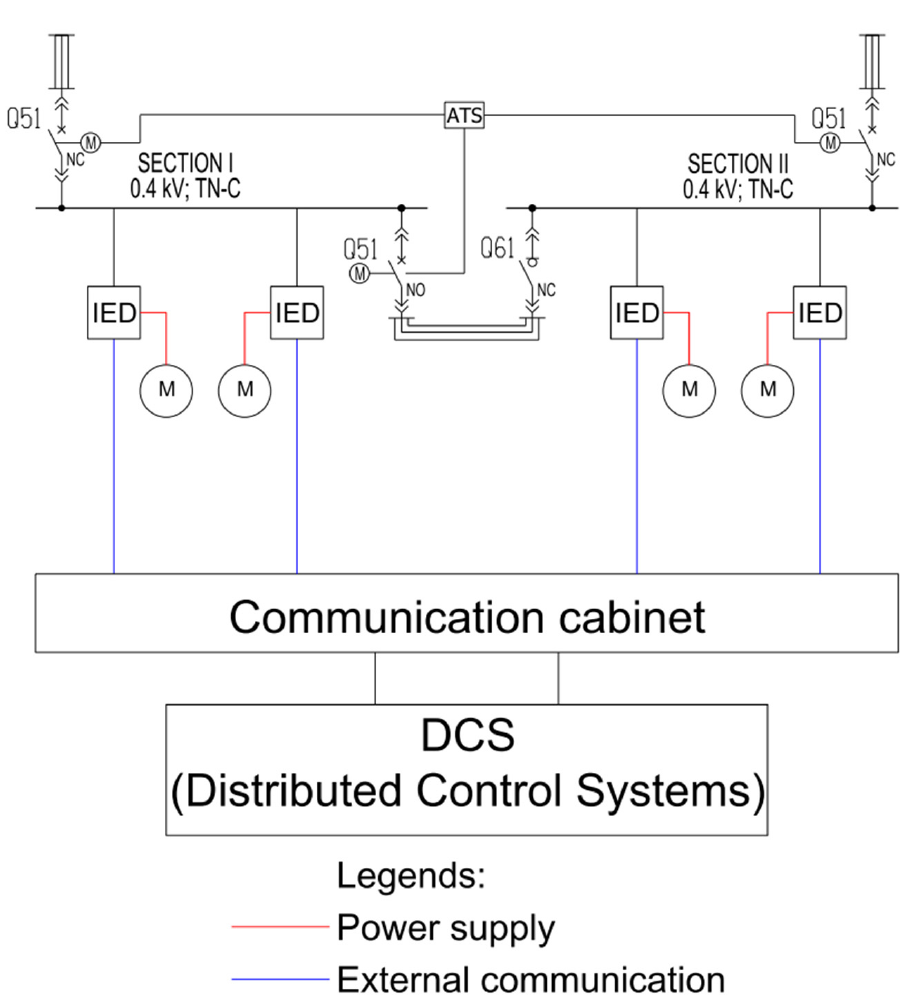
Figure 1. Topology of the direct connection between the controller and the supervisory system DCs.